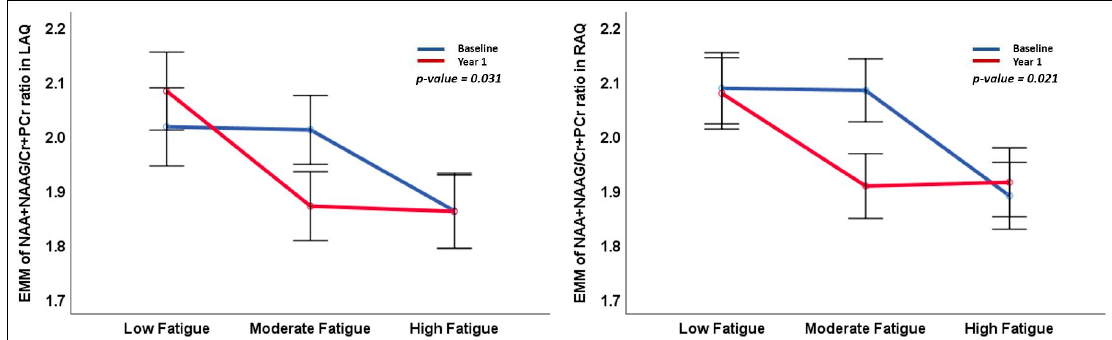
Figure 3. Line graphs represent the estimated marginal mean and standard error of mean (SEM) of the NAA+NAAG/Cr+PCr ratio in the right anterior quadrant (RAQ) and the left anterior quadrant (LAQ) between the fatigue groups at baseline and year 1. The p -value represents the statistical significance of the main effect of fatigue groups in the two-way ANOVA.